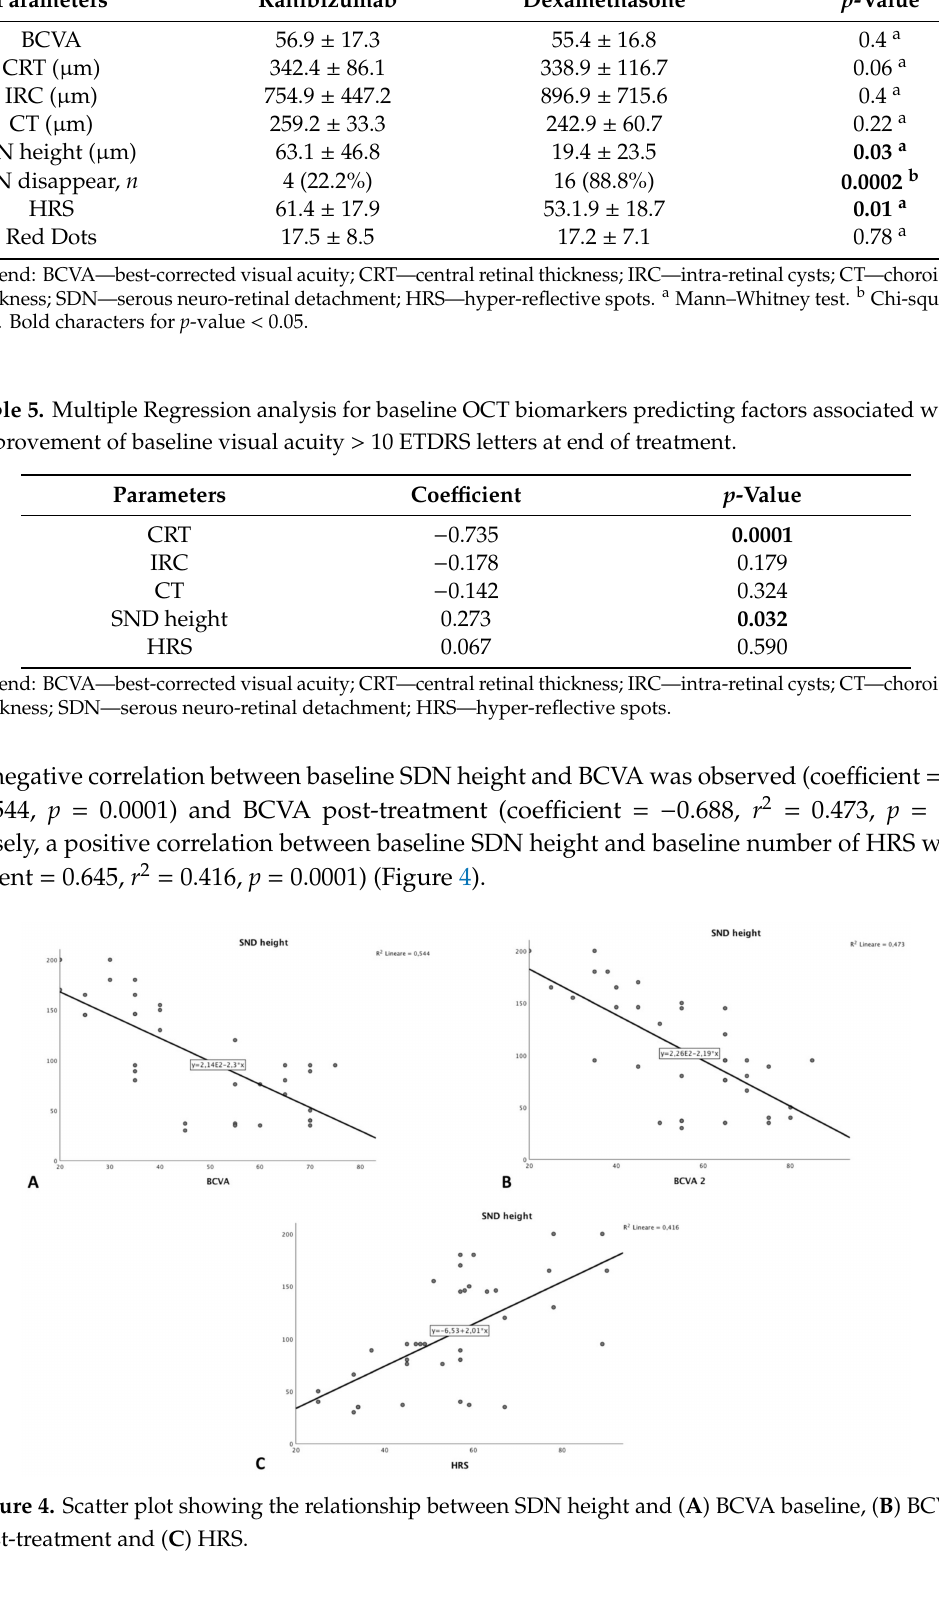
Table 4. Comparison of post-treatment data between the dexamethasone and ranibizumab groups. Parameters